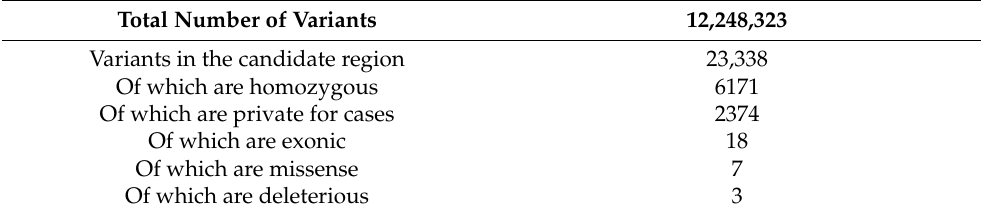
Table 1. Variants identified via the whole genome sequence of GLPs.